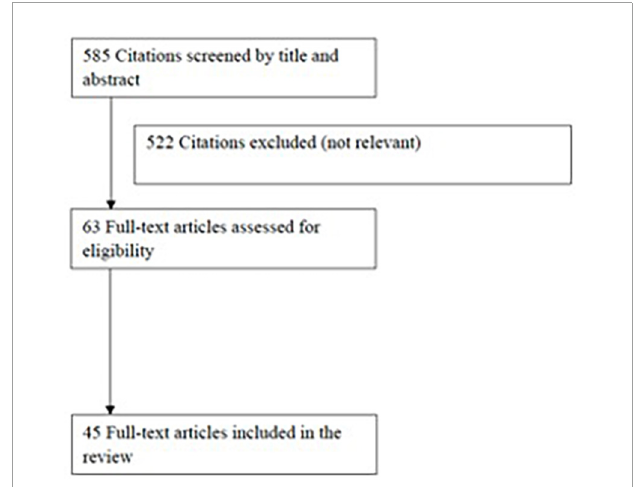
FIGURE1 Study flow diagram according to the preferred reporting items for systematic review and meta-analysis protocols